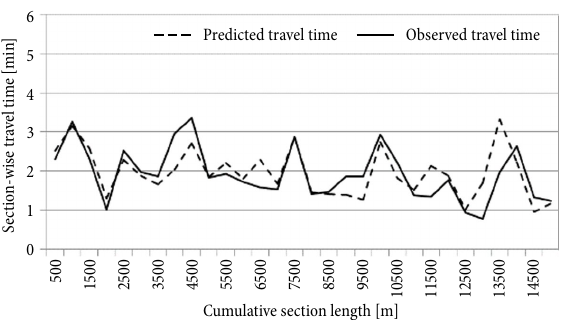
Fig. 9. Plot of predicted and actual section-wise travel times of TV in 23C route